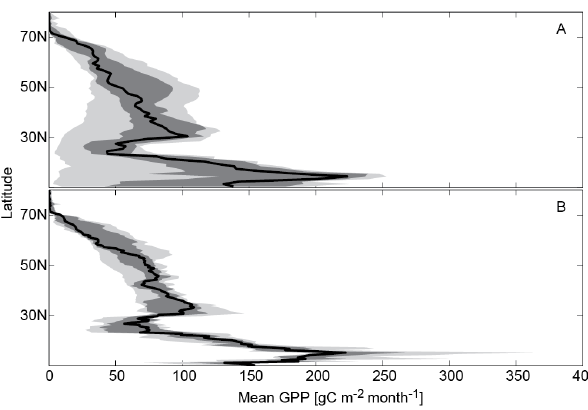
Figure 5 Fig. 5. North American multi-year mean (2000–2005) GPP from (A) the NACP regional and continental interim synthesis (RCIS) and (B) the MsTMIP simulations for 5 models (CLM, DLEM, LPJ- wsl, ORCHIDEE-LSCE, and VEGAS). On each panel, the solid line shows the median of the multi-model ensemble, the darker shaded area shows the interquartile range; and the lighter band shows the full range in